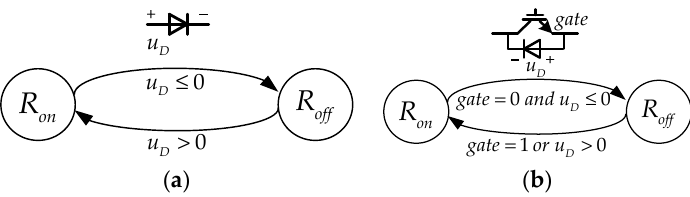
Figure 1. Diode-status-updating state machines: ( a ) diode; ( b ) diode connected in parallel to an insulated gate bipolar transistor (IGBT).